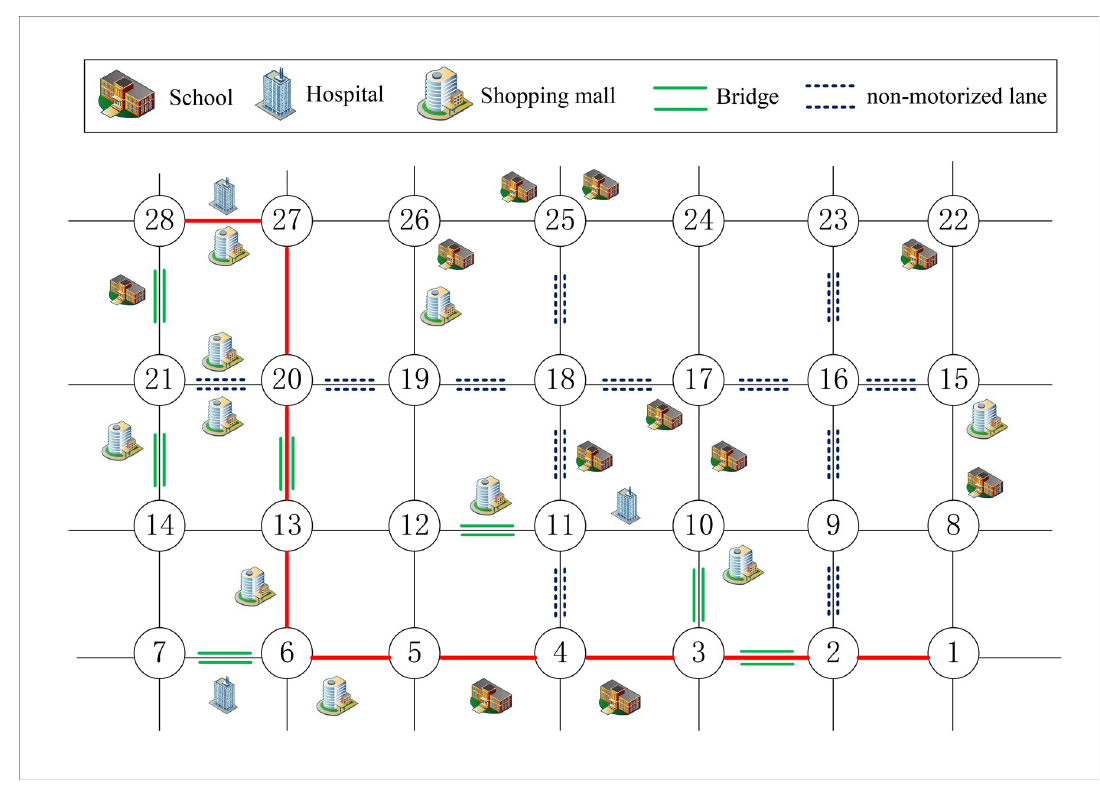
Fig 5. Time-consuming shortest